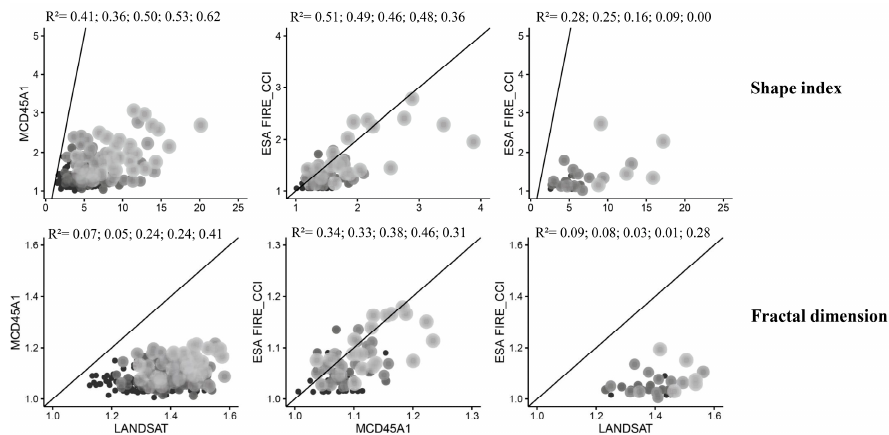
Figure A2. Correlations of patch metrics (Shape Index and Fractal Dimension) for comparison: 1—LANDSAT × MCD45A1, 2—MCD45A1 × ESA FIRE_CCI and 3—LANDSAT × ESA FIRE_CCI. The grey scale color of individual points correspond to their patch size class from 90 ha (black), 270 ha, 450 ha, 630 ha, to 900 ha (light grey). The R squared values indicate the coefficient of determination ordered in according to patch size class.